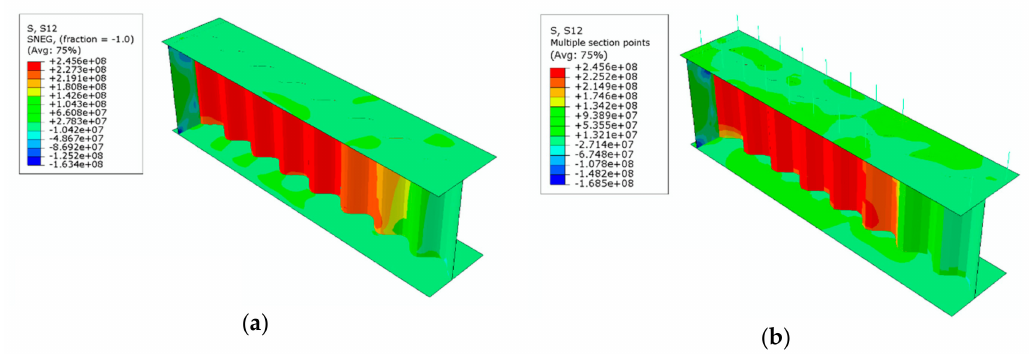
Figure 13. Pre-buckling shear stress distribution in the sinusoidal web (unit: Pa): ( a ) steel beam; ( b ) beam bonded to a reinforced concrete slab (view without the slab).